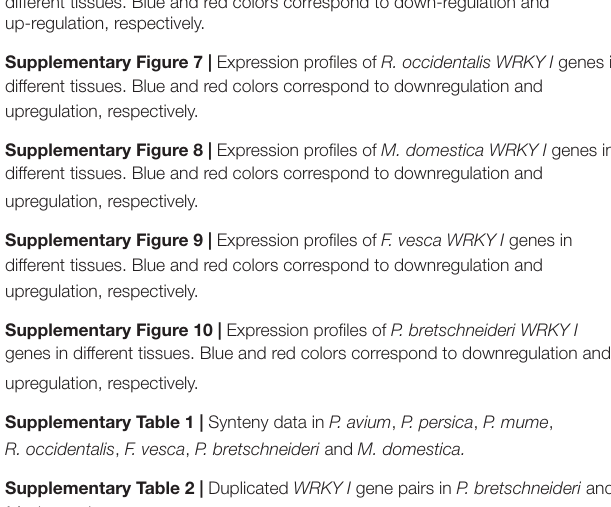
Supplementary Table 2 | Duplicated WRKY I gene pairs in P. bretschneideri and M. domestica. Supplementary Table 3 | The divergence between duplicated WRKY I gene pairs in P. bretschneideri and M. domestica . Supplementary Table 4 | Primers in this